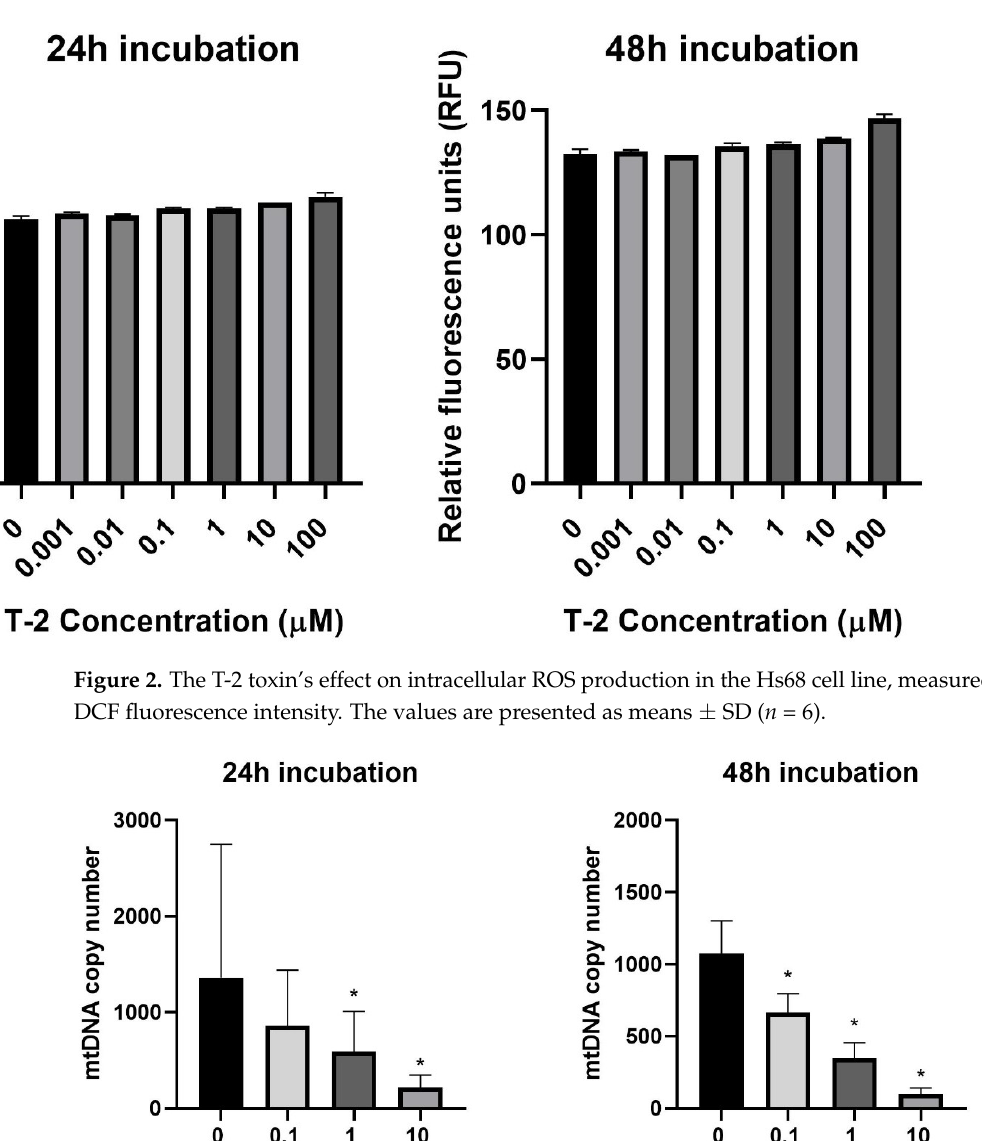
Figure 3. The T-2 toxin’s effect on the mitochondrial DNA copy number in the Hs68 cell line, measured by real-time quantitative polymerase chain reaction (rt-qPCR). The values are presented as means ± SD ( n = 6). * p < 0.05.